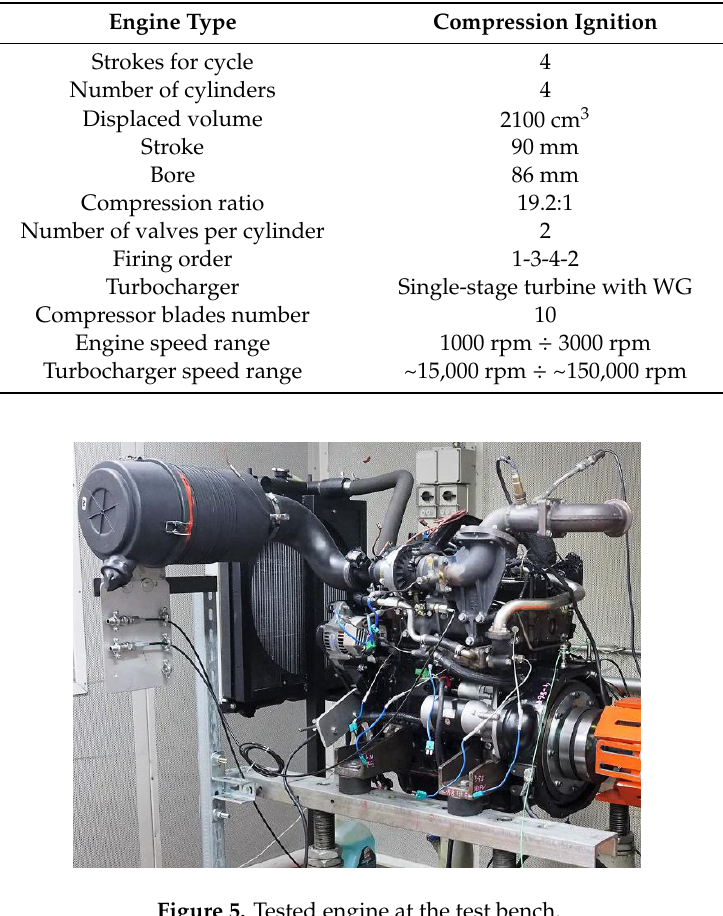
Figure 6. Hall effect sensor installed on the compressor case.